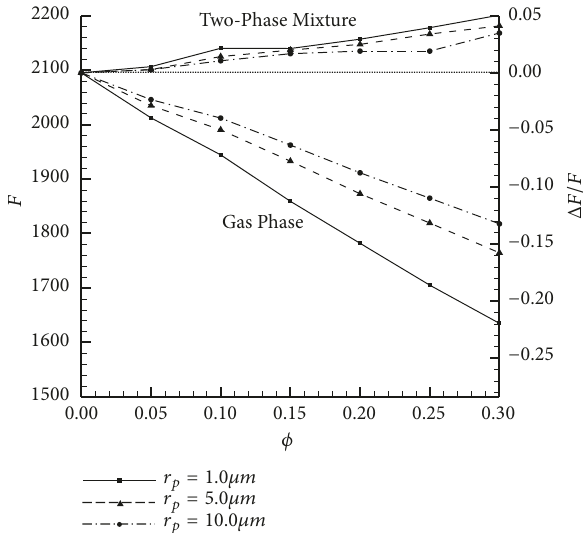
Figure 10: Effect of particle mass fraction and size on